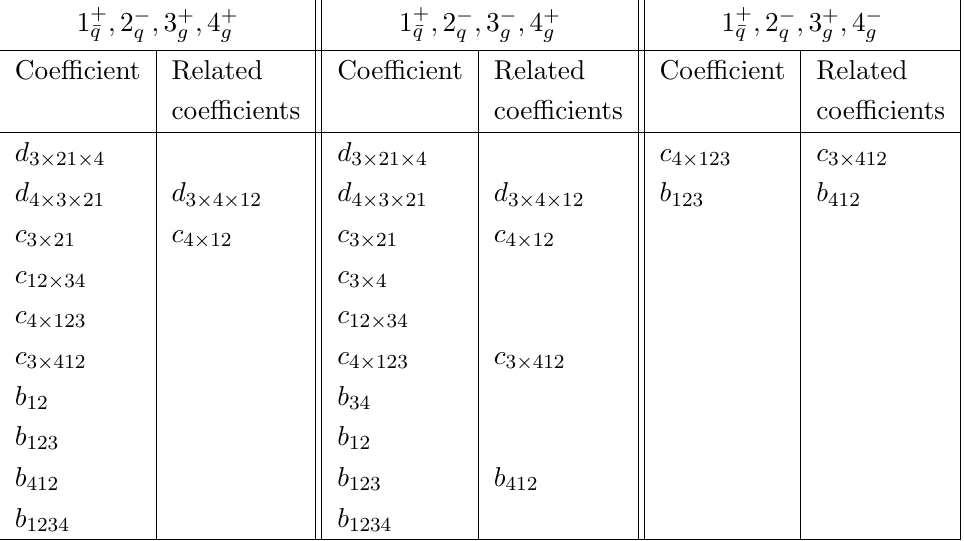
(1 + ; 2 (cid:0) ; 3 + ; 4 + ), H 34 (cid:22) q q g g 4